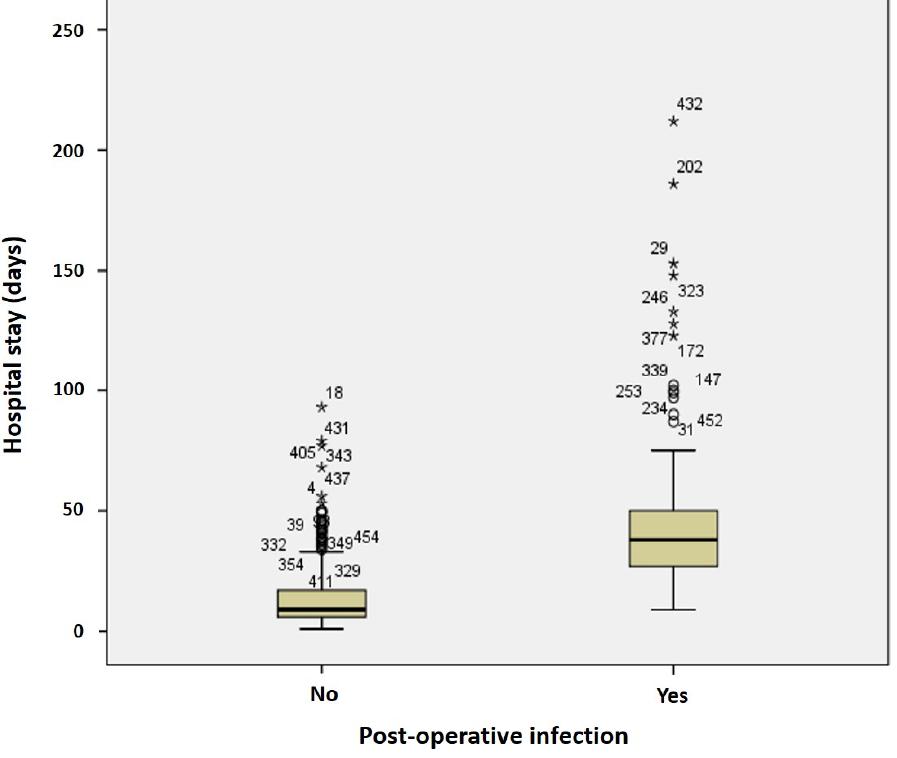
Figure 2. Median hospital stay according to infection status. Outliers are present in the figure as asterisks and circles. asterisks and